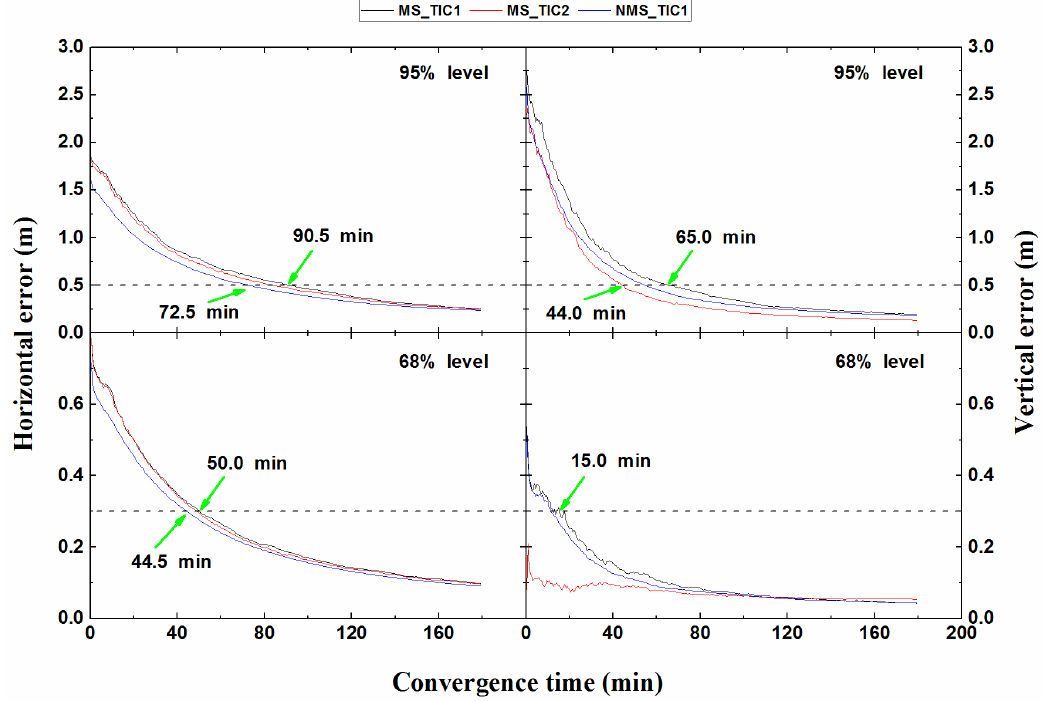
Figure 7. The GPS static SF PPP convergence performance in different constraint schemes during the MS and NMS periods.